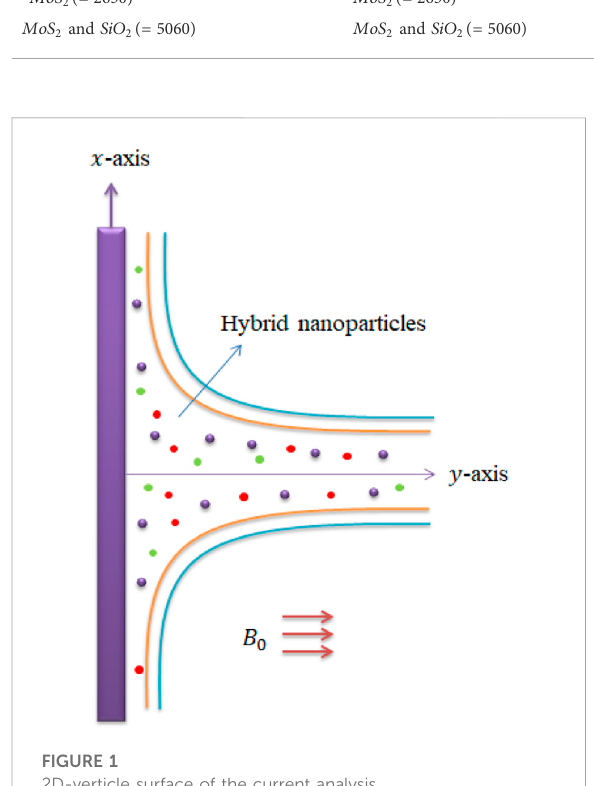
FIGURE 1 2D-verticle surface of the current